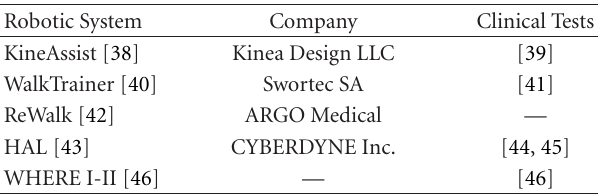
Figure 7: KineAssist robotic device (picture courtesy of Kinea Design, LLC). Table 3: Overground gait trainers.